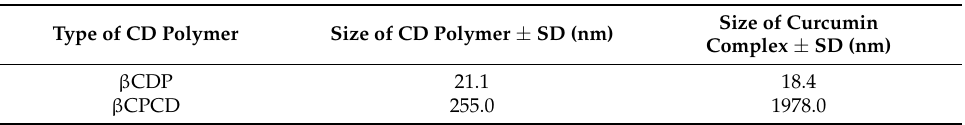
Table 2. The average sizes of β CDP and β CPCD and their curcumin complexes in purified water (data are presented as means ± SD; n =